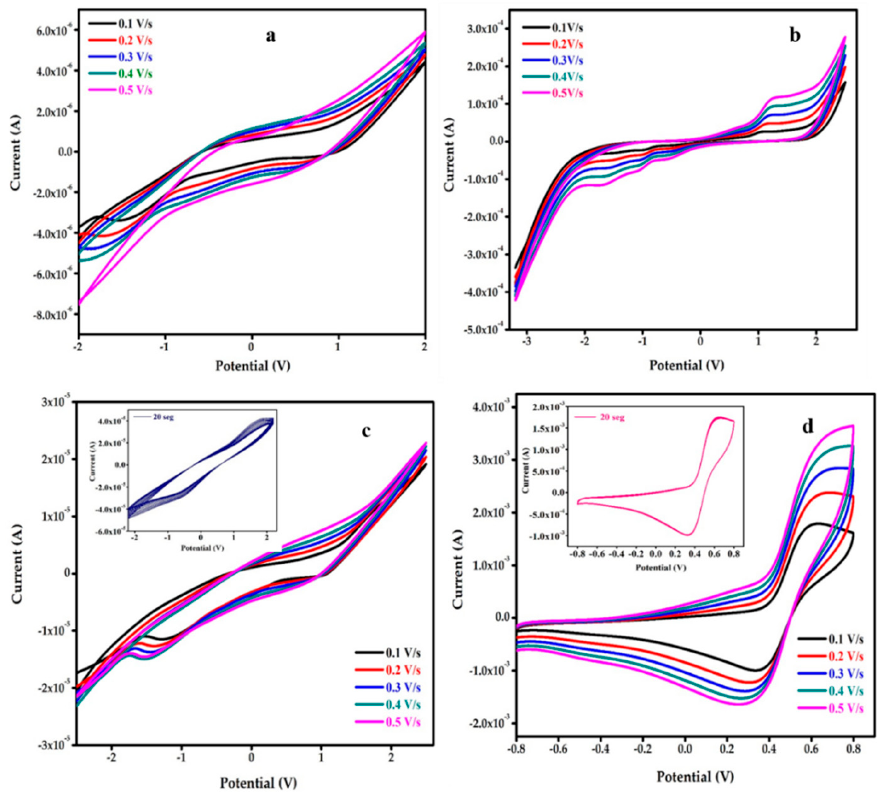
Figure 6. CV curves of ( a ) PPy, ( b ) GQDs. ( c ) PGC2 composite ( d ) PGC4 composite at different scan rates 0.1 to 0.5 V/s. The inset is the CV curves of composites at 20 segments at a 0.1 scan rate. The potential range of − 2 to 2 V for PPy, − 3 to 3 V for GQDs and PGC2, and − 0.8 to 0.8 V for PGC4 composite at different scan rates were used here. As the scan rate increases from 0.1 to 0.5 V/s, the corresponding current increases, suggesting that the current is directly proportional to the square root of the scan rate. The CV curves of the PGC4 composite show a rectangular shape confirms the good electrochemical